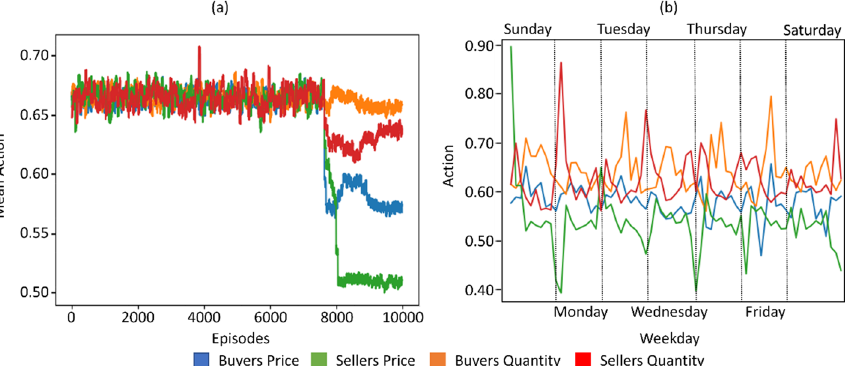
Fig. 10 Actions chosen by agents: ( a ) Average of actions throughout the training ( b ) Average of actions chosen in the post-training